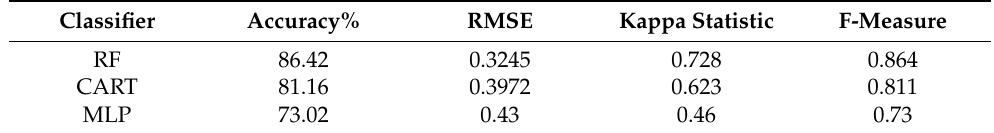
Table 2. Evaluation